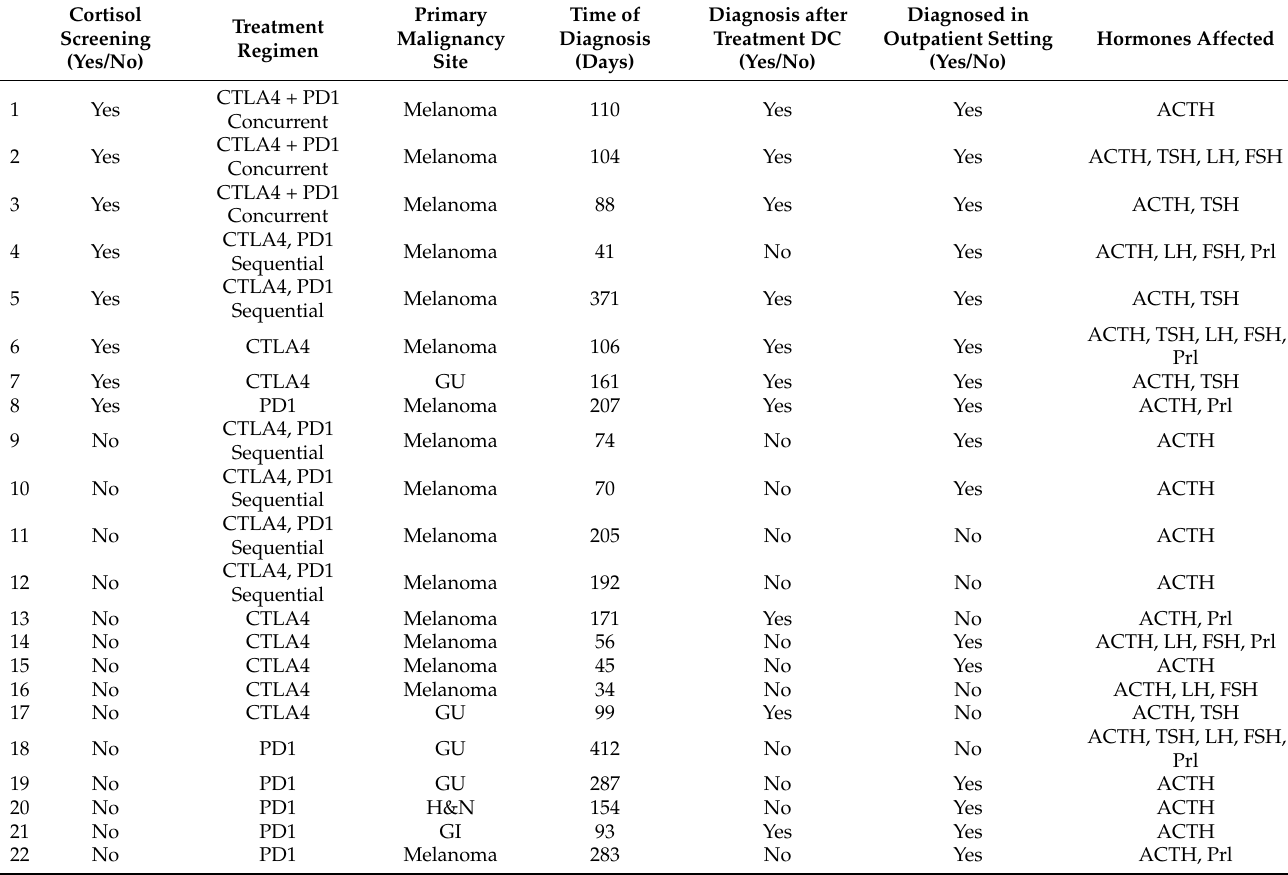
Table 3. Details of patients in cohort who had confirmed